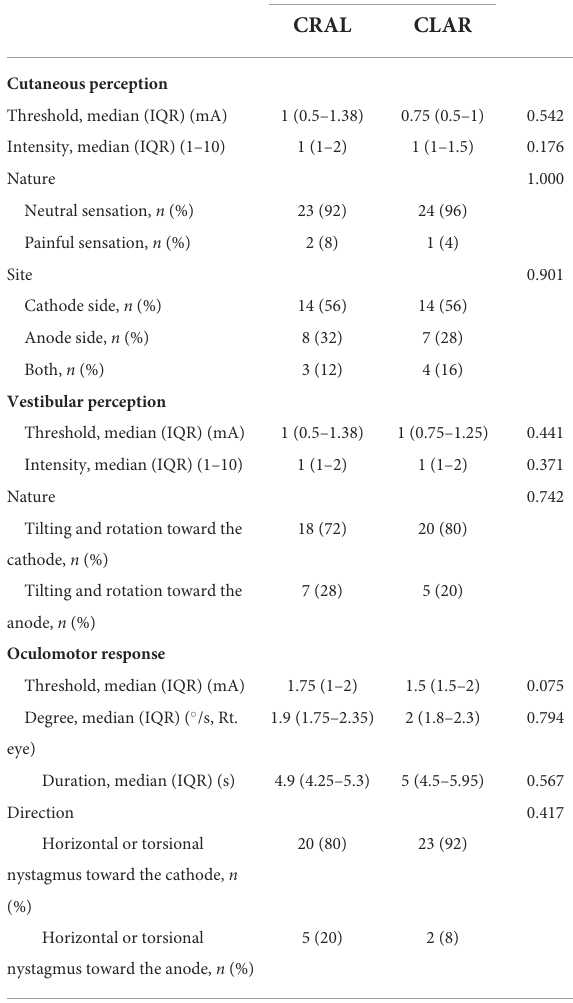
TABLE 3 Comparison of the properties of cutaneous and vestibular perception and oculomotor response depending on the CRAL and CLAR GVS